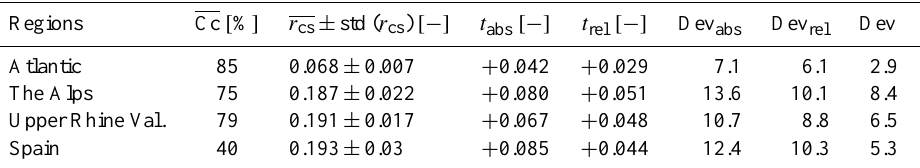
Table 2. Results of the HRV cloud mask algorithm averaged over three 16-day periods starting 1 June, 1 July and 1 August 2011. The four regions considered are listed in column 1. Cc is the average cloud cover, and r cs is the spatially averaged temporal median HRV clear-sky reflectance including its standard deviation std( r cs ). Columns 4 and 5 report the cloud detection thresholds above which a pixel is classified as cloudy. t abs lists the absolute threshold without use of the HRV clear-sky reflectance composite, while t rel is the threshold relative to the composite. The percentage deviations between the HRV and the EUMETSAT cloud mask are given in columns 6–8. Here, Dev abs and Dev rel are the deviations found using t abs and t rel , respectively. Column 8 lists the final deviation Dev fi after applying the HRV clear-sky composite and thin cloud restoral.